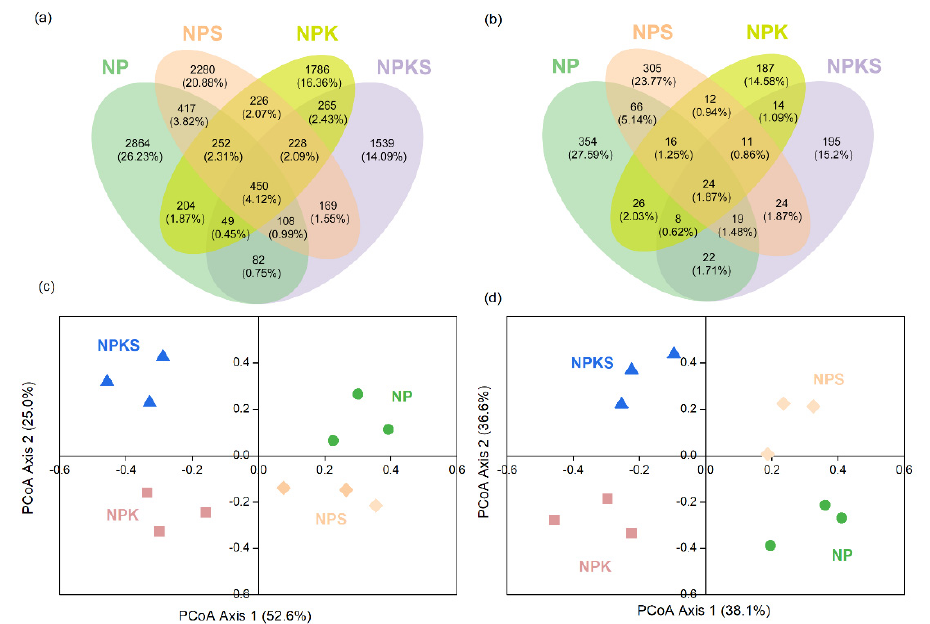
Figure 4. Venn diagram of ( a ) bacterial and ( b ) fungal operational taxonomic units from soil samples and the principal coordinates analysis (PCoA) plot of the dissimilarity between the treatments for ( c ) bacteria and ( d ) fungi based on Bray–Curtis differences.